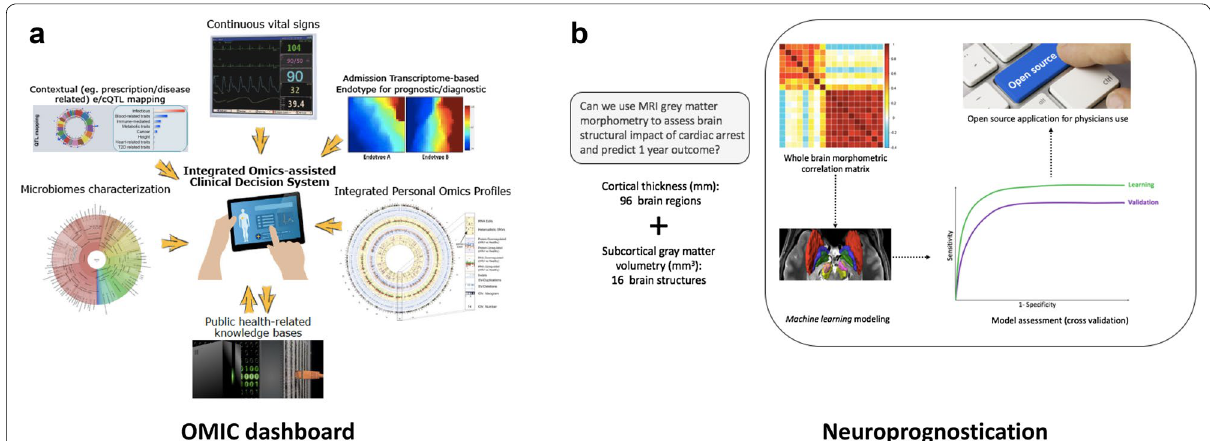
Fig. 1 Data‑driven methods applications . A. Potential ICU dashboard. It will integrate multimodal sources of big data, leveraging on continuous monitoring information, personal omics data sets, public health‑related databases, medical notes and prescribed treatments. Probably, future